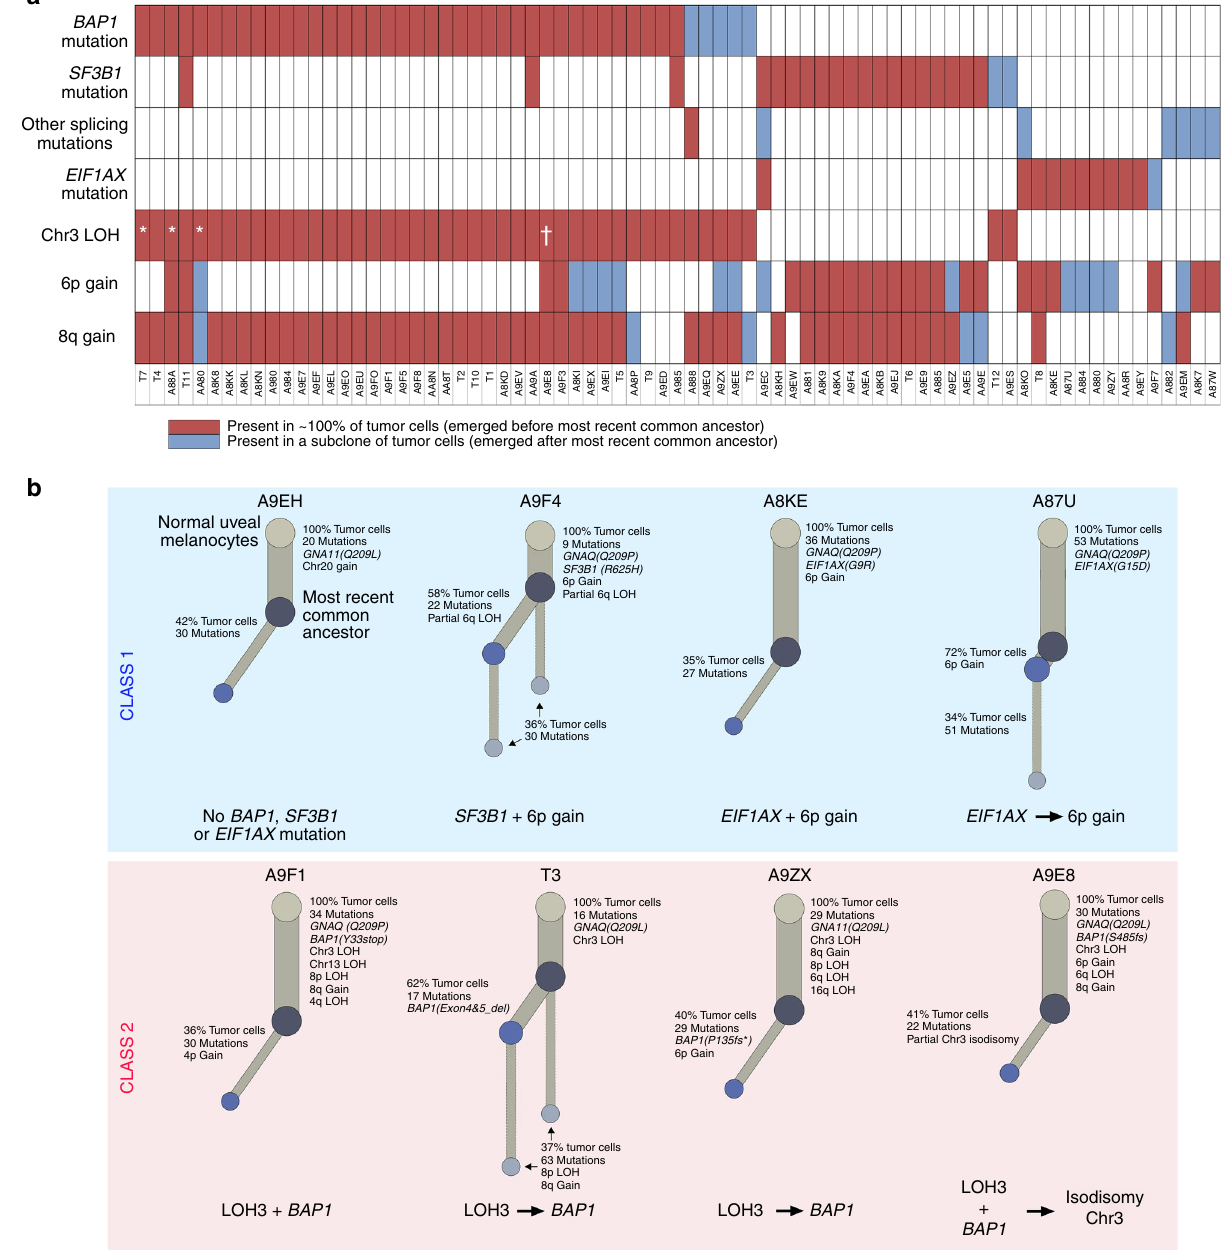
Fig. 4 Clonal evolution in uveal melanoma. a Clonal relationships between canonical driver mutations and chromosome copy number alterations. Red bars denote aberrations that are present in 100% of tumor cells and thus arising before the most recent common ancestor (MRCA). Blue bars denote aberrations present in a subclone of < 100% tumor cells arising subsequent to the MRCA. A white bar denotes that the aberration was not present. *Isodisomy 3 in 100% of tumor cells; † isodisomy 3 in a subclone of < 100% of tumor cells. b Life history clonal evolution plots for eight representative uveal melanoma samples. Blue box illustrates class 1 tumors with no BSE mutations (A9EH), SF3B1 and 6p gain in 100% of tumor cells (A9F4), EIF1AX and 6p gain in 100% of tumor cells (A8KE), and EIF1AX in 100% of tumor cells and 6p gain in a subclone (A87U). Red box illustrates class 2 tumors with LOH3 and BAP1 in 100% of tumor cells (A9F1), LOH3 in 100% of tumor cells, and BAP1 mutation in a subclone (T3 and A9ZX), and LOH3 and BAP1 in 100% of tumor cells with later duplication of chromosome 3 to generate isodisomy 3 in a subclone (A9E8). The node at the top of each plot (light grey circle) represents normal uveal melanocytes, the presumed precursor cell that gives rise to all uveal melanomas. The next lower node (dark gray circle) represents the most recent common ancestor (MRCA) from which all aberrations present in 100% of tumor cells arose. Lower nodes (blue circles) represent subclones that arise after the most MRCA, with the area of the node being proportional to the percentage of cells in the subclone. The mutations and CNAs that occur between two nodes are indicated beside the connecting branch (gray bar). The length of each branch is proportional to the number of mutations that occur between nodes and the width of the branch is proportional to the percentage of cells containing those mutations. When a node contains rare aberrations that cannot be accurately mapped to one node, it is mapped to all possible nodes, as described in